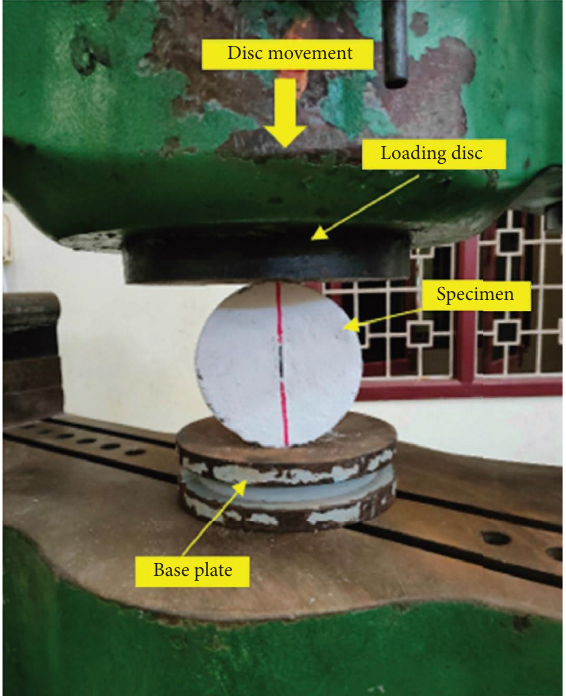
Figure 6: Experimental